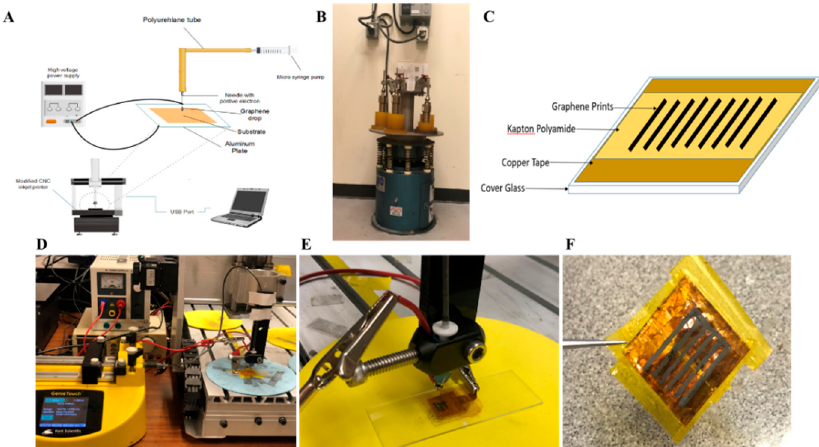
Figure 1. Schematic of the drop-on-demand graphene printing method. ( A ) An abridged general view of the printer setup. ( B ) A graphene solution was mixed using a Vibro-Energy mill (shaker mill) for 90 h at 300 rpm. ( C ) Schematic of chip setup. ( D ) Equipment setup during printing. A syringe pump was used along with an inkjet printer to deposit ink at a rate of 7 µL/s to ensure a constant flow rate throughout the syringe. ( E ) Needle and substrate setup. A 3 kV potential difference was introduced between the substrate and needle for the purpose of affixing ink onto the substrate. A cover glass was placed on a regular microscope slide for stability and support. ( F ). Printed chip end result of 3D printed